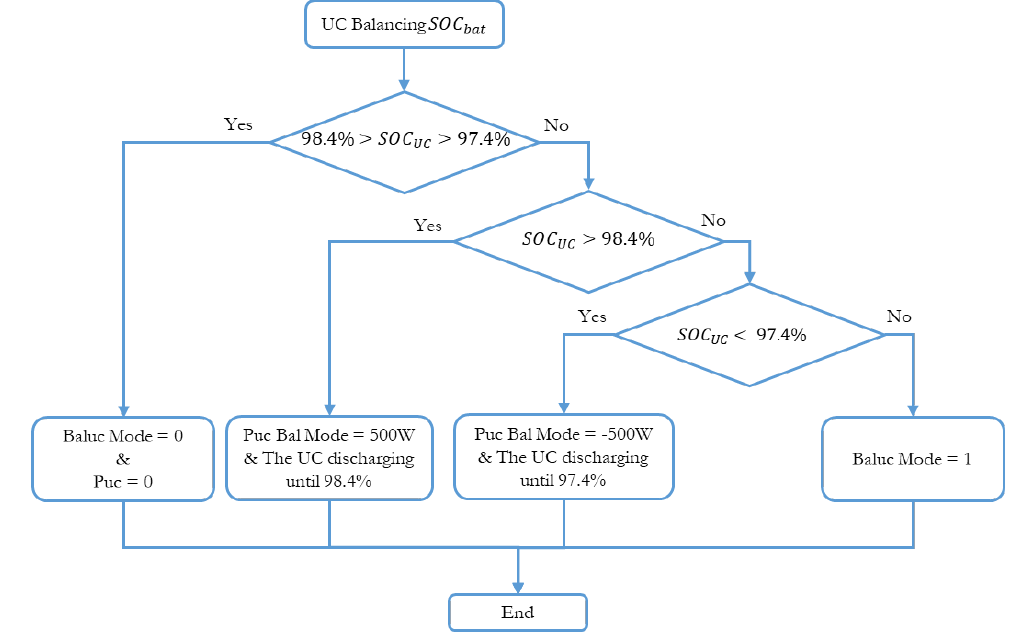
Figure 15. Flowchart of ultracapacitor level balancing